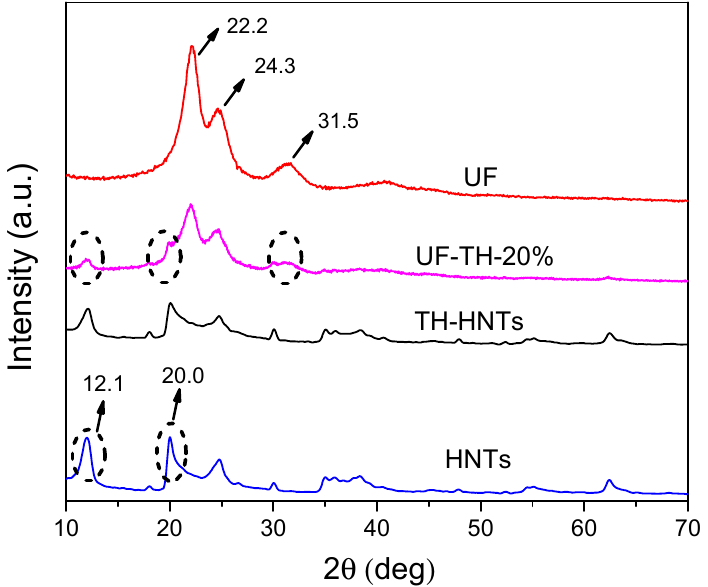
Figure 2. XRD diffraction patterns of HNTs, TH-HNTs, UF, and UF-TH-20%. Figure 3 showed the SEM images of pristine HNTs, TH-HNTs, UF, UF-H-20%, and UF-TH-20%. The surface of HNTs was smooth, while the surface of TH-HNTs became rough. This is because the coupling agent covered the HNTs [60]. It could be seen from (c) that UF were the irregular particle. The images of UF-H-20% and UF-TH-20% were apparently different from that of UF. It is noted that the UF-TH-20% particles were spherical. Compared to UF-H-20%, TH-HNTs were dispersed more averagely in the polymer resin, showing that TH-HNTs were compatible with polymer more easily.